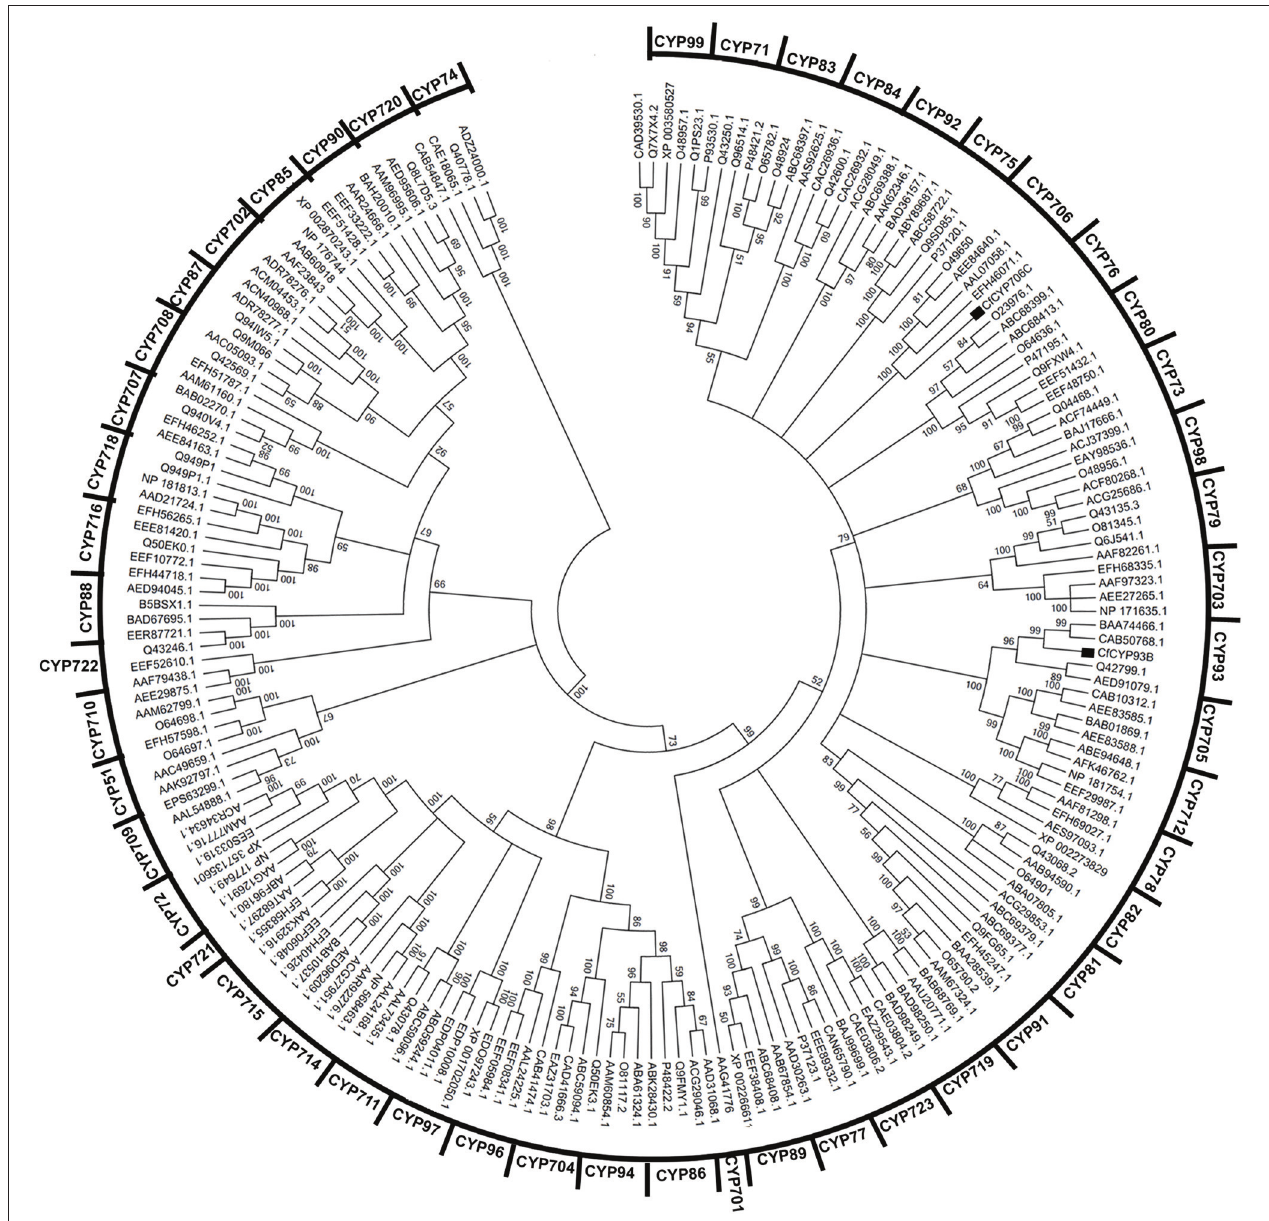
FIGURE 2 | Clustering of CfCYP93B and CfCYP706C from C. forskohlii with members from all major plant CYP450 families. MEGA5 software was used for the analysis. Tree topology support was assessed by bootstrap analysis (1000 replicates).